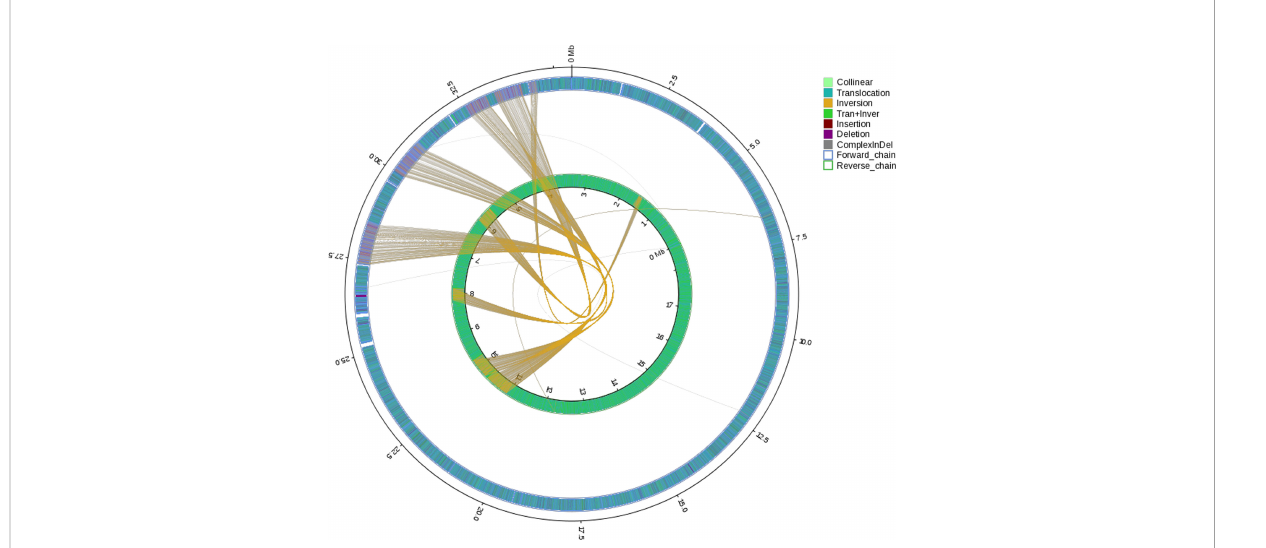
FIGURE 2 Rearrangements and inversions in genome BMU 04928 compared with BMU 00512 taken as reference genome. Collinear: synlinear region; Translocation: translocation region; Inversion: inversion region; Tran+Inver: translocation and inversion region; Insertion: insertion region with length ≥ 50 bp; Deletion: deletion region with length ≥ 50 bp; ComplexInDel: Regions that do not match but those locations correspond; Forward chain: the forward chain of the genome sequence, and the gene coordinates increase in the clockwise direction; Reverse chain: the reverse chain of the genome sequence, and the gene coordinates increase in the counterclockwise